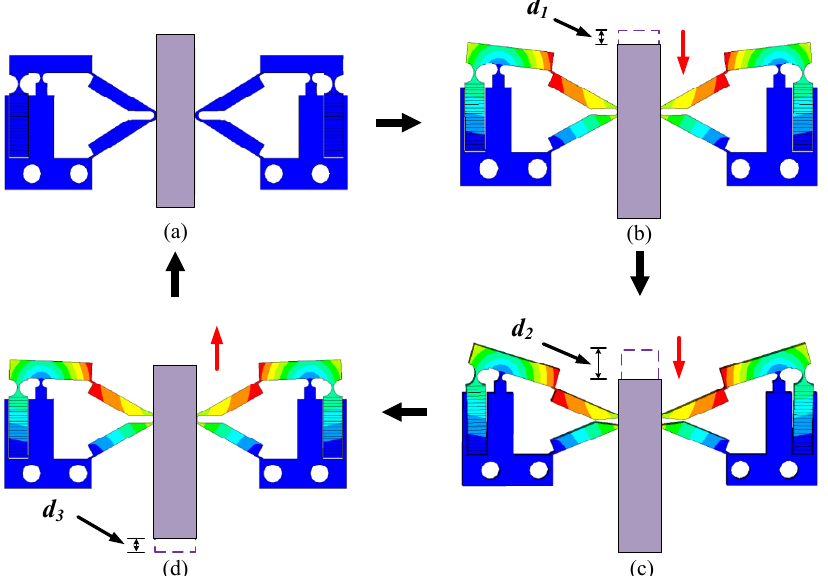
Figure 14. Operation process of the PEAs in one cycle; ( a ) Initial state; ( b ) Steady state; ( c ) Maximum steady state; ( d ) Sliding state.